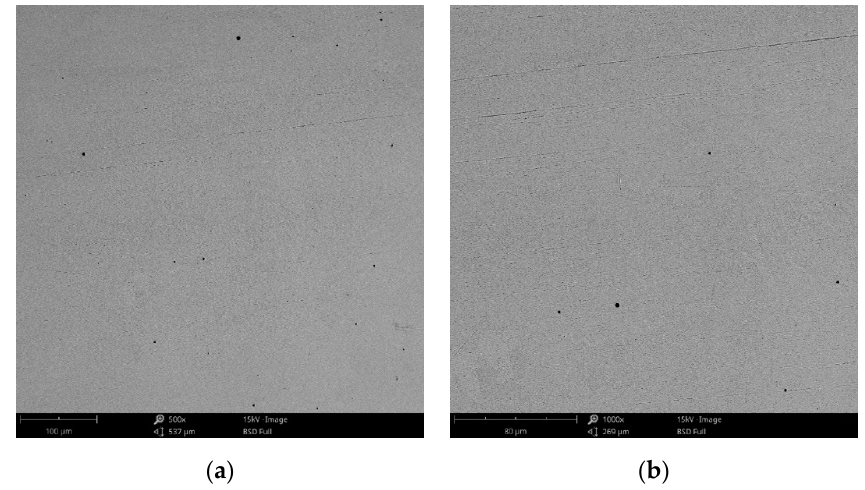
Figure 16. SEM images of the CCm-5 sample after corrosion tests at ( a ) 500×; ( b ) 1000×.